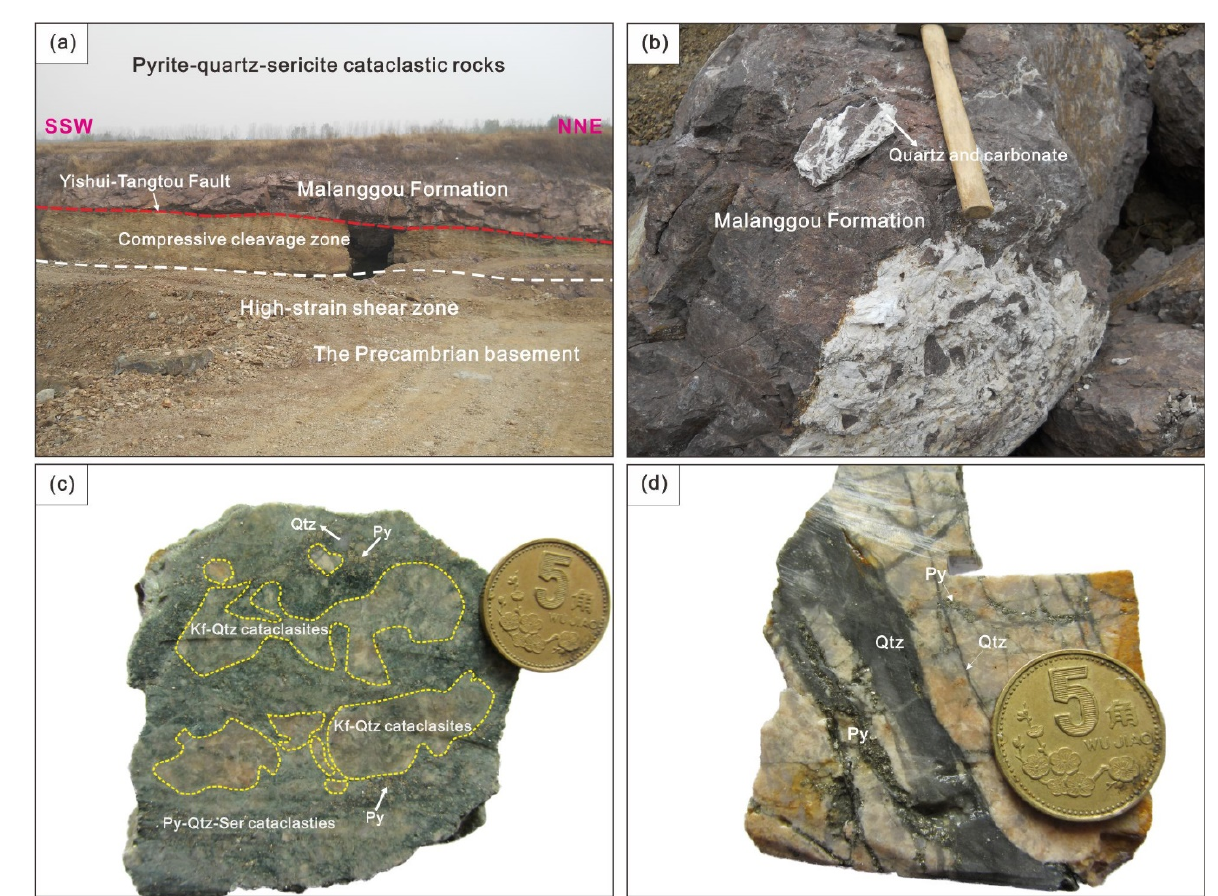
Figure 4. Geology, ore type, and mineralization features of the Longquanzhan gold deposit. ( a ) Panoramic view of the Yishui-Tangtou fault; ( b ) breccias of the Cretaceous Malanggou Formation, with cementing materials of quartz and carbonate; ( c ) altered rock-type ores with early K-feldspar overprinted by late pyrite, sericite, and quartz; and ( d ) gold-bearing quartz vein/veinlets within the footwall gneissic monzogranite. Abbreviations: Py =pyrite; Ser = sericite; Qtz = quartz; Kf = K-feldspar.